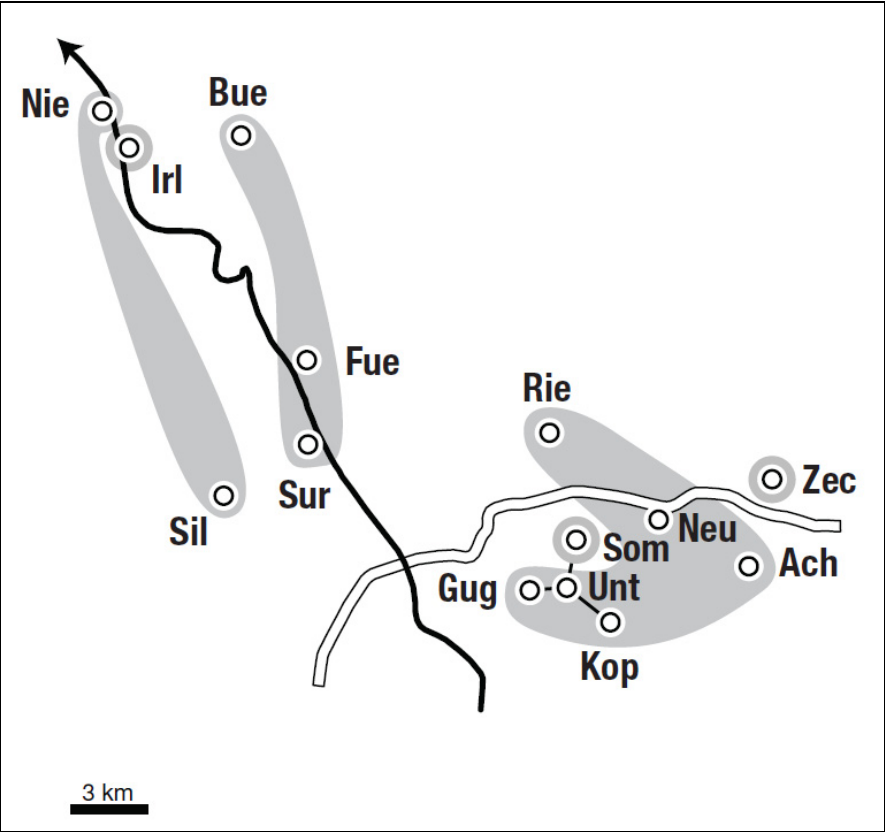
Figure 2. Neighbourhood contiguity by distance graph (NCDG) of sampled localities assuming upper bounds of 3.000 m, as well as genetic clusters (C1-C6) calculated by Baps (highlighted in grey, posterior probability p = 0.866); “Salzach” river (bold line), highway A1 (white